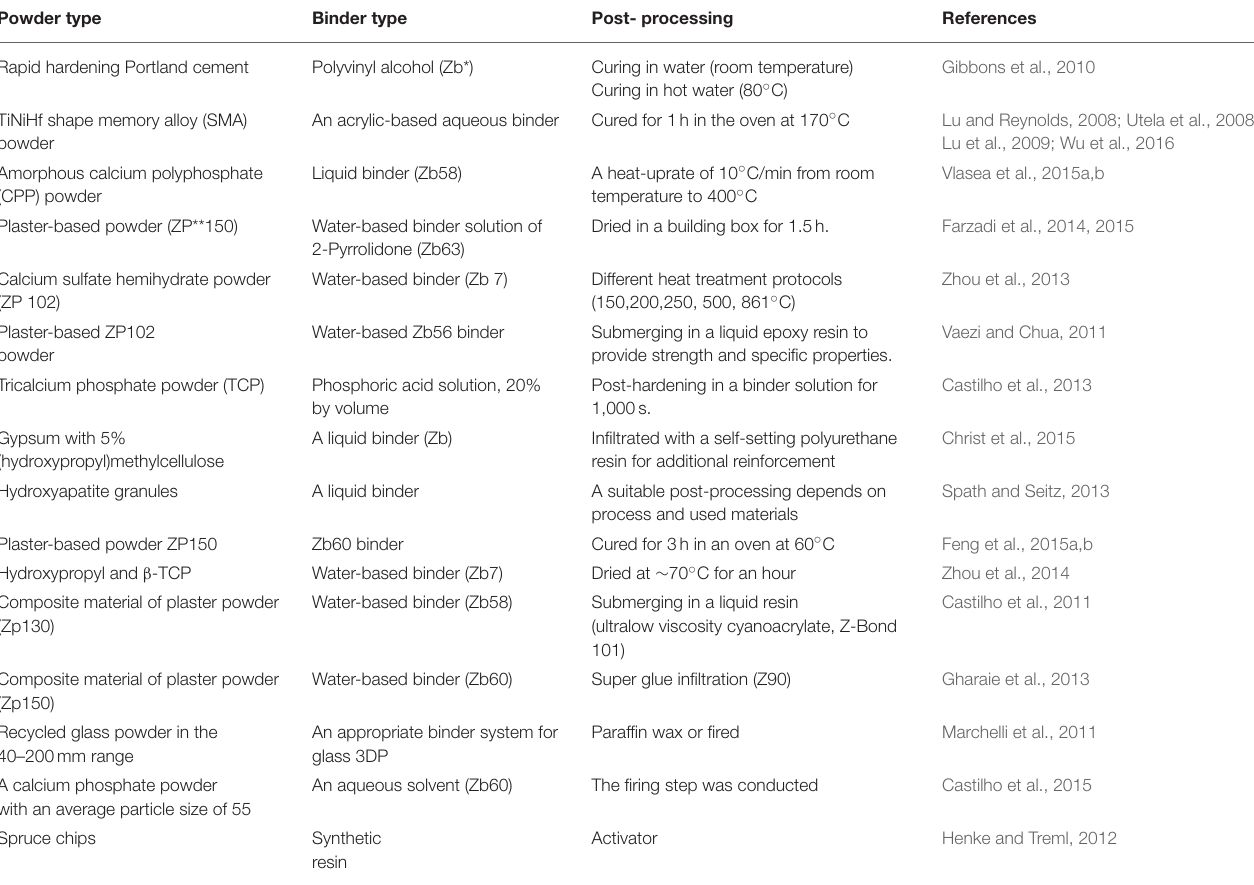
TABLE 1 | Types of powder, binder, and post-processing for the Inkjet